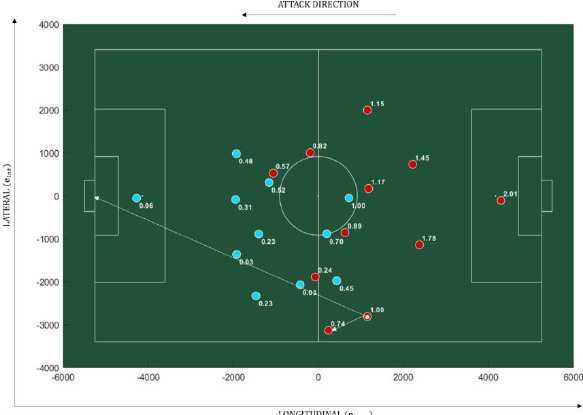
Figure 1. The player-ball-goal angle (PBGA). The numbers next to each player represent the PBGA in radian, measured with the vertex on the ball (white filled circle), considering the ball-player and ball-goal vectors, illustrated by the white arrows.